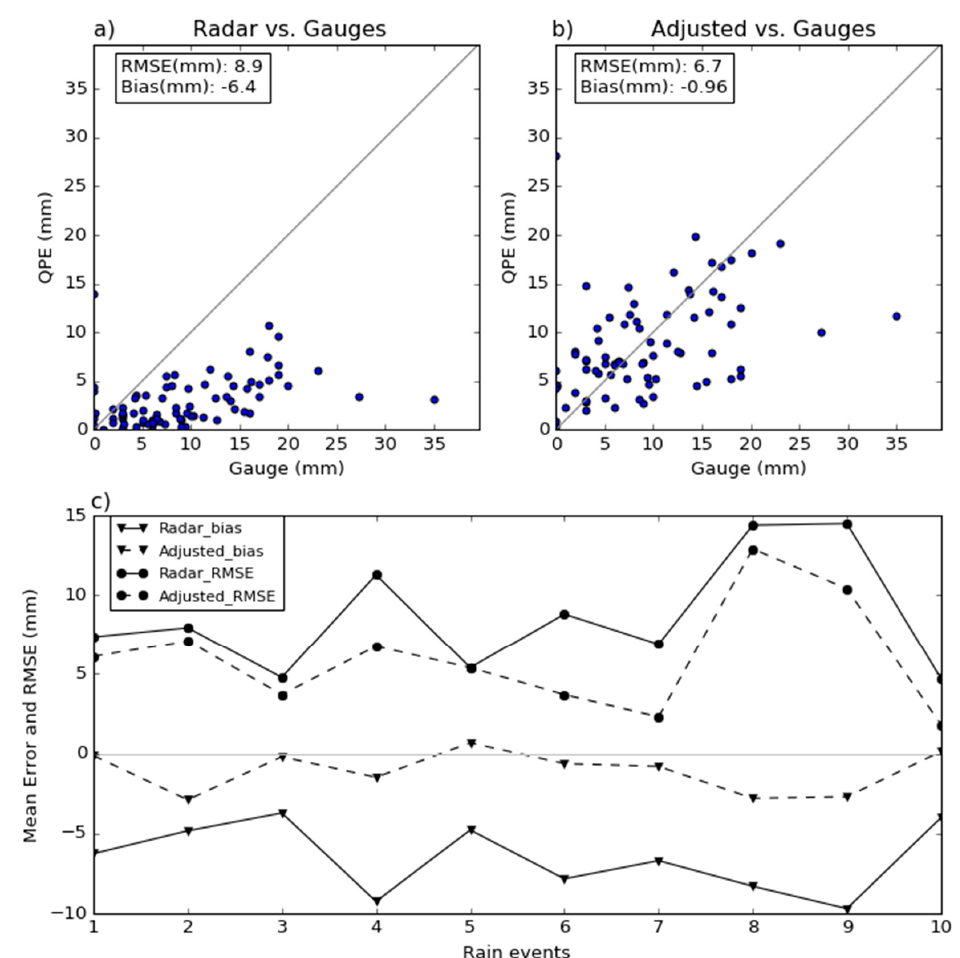
Figure 4. ( a ) Scatter plots of 24 h radar-only QPE distribution and ( b ) the cross-validation of 24 h adjusted QPE versus the gauge observations for all the studied rainfall events. ( c ) Statistics in term of bias (triangle) and root mean square error (RMSE) (dot) of the radar-only QPE versus gauges (solid) and cross-validation of the adjusted QPE (dashed) for the 10 studies cases.